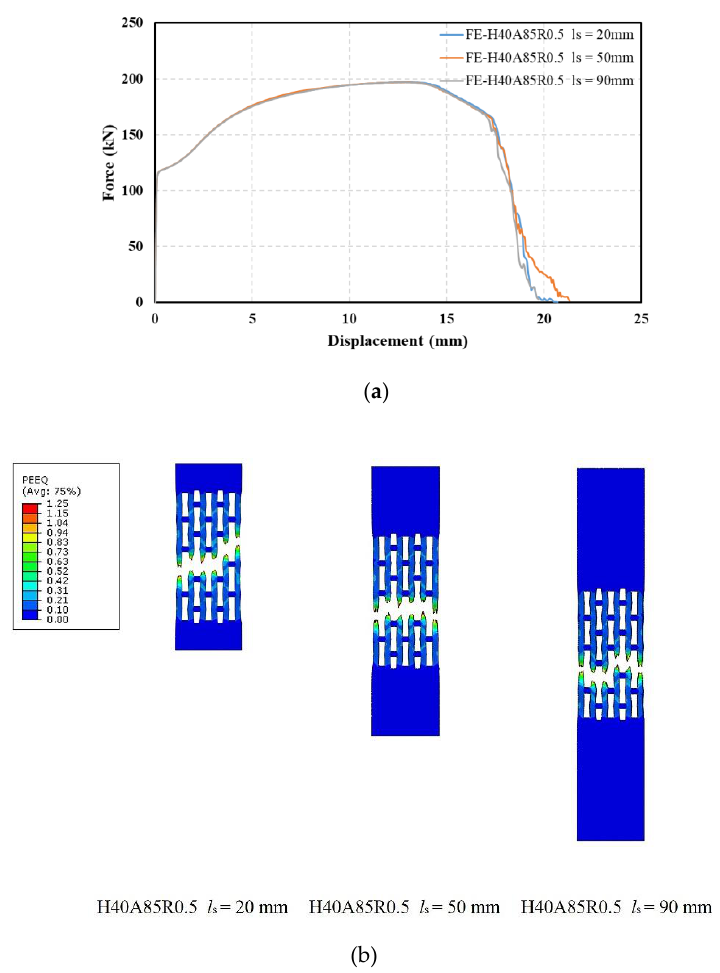
Figure 23. ( a ) Load – displacement curves and ( b ) failure modes of specimens with different solid areas.